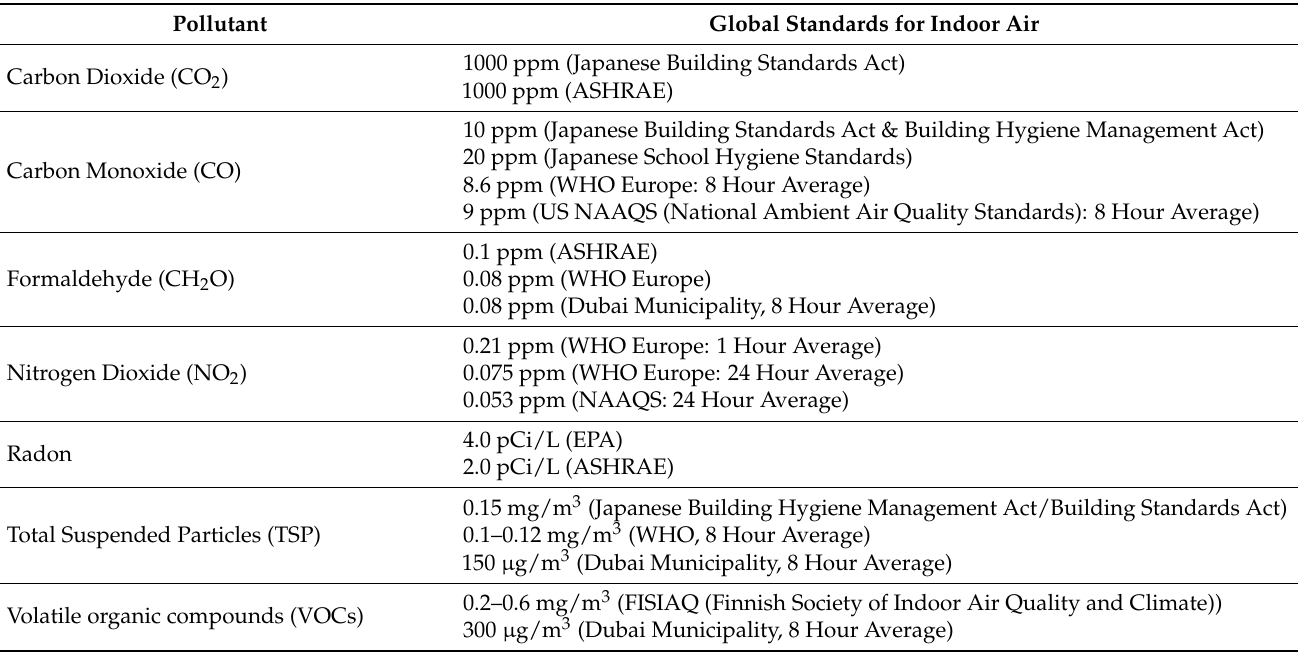
Table 1. Global standards for indoor air